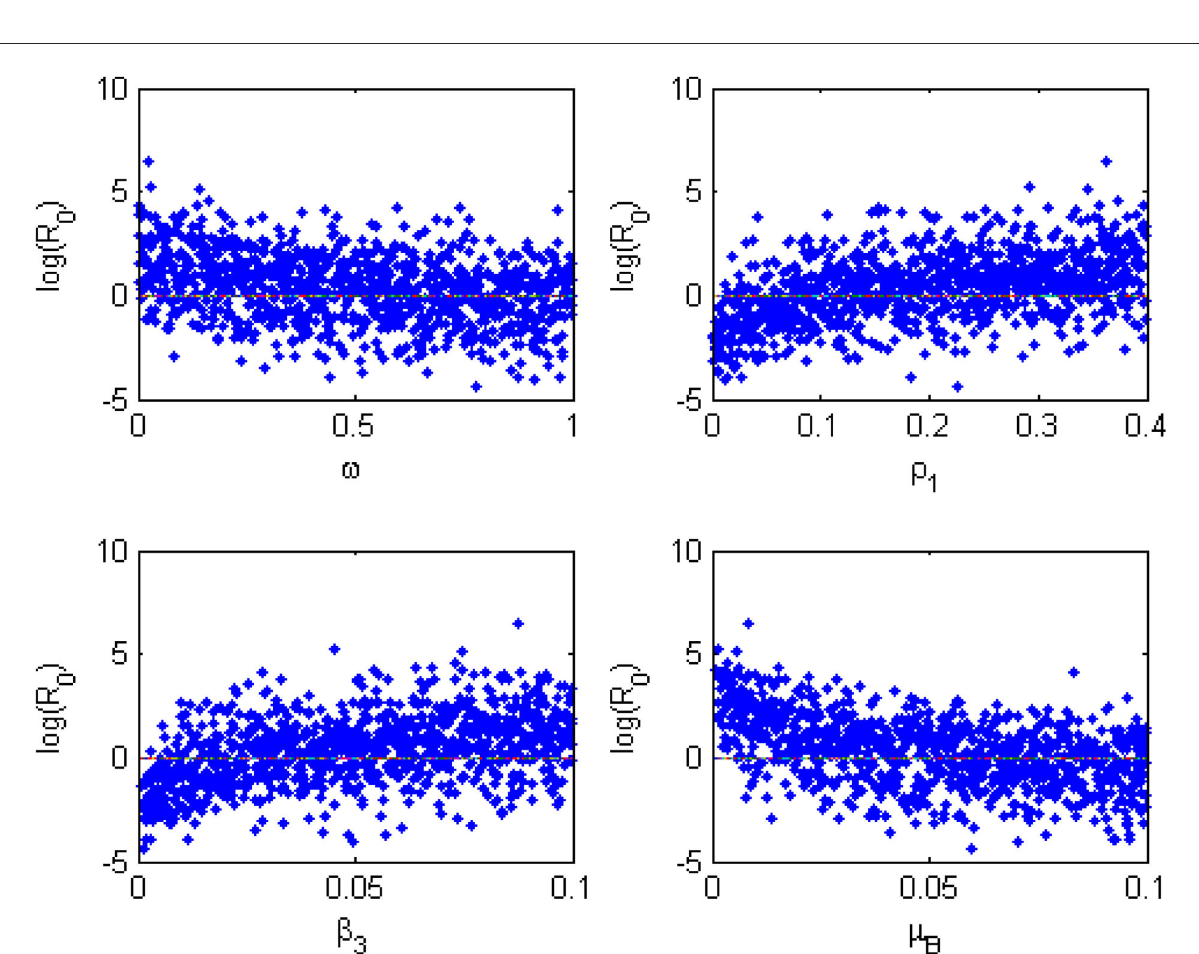
FIGURE5 Monte Carlo simulations for the most sensitive parameters of the model generated using the parameter values in Table